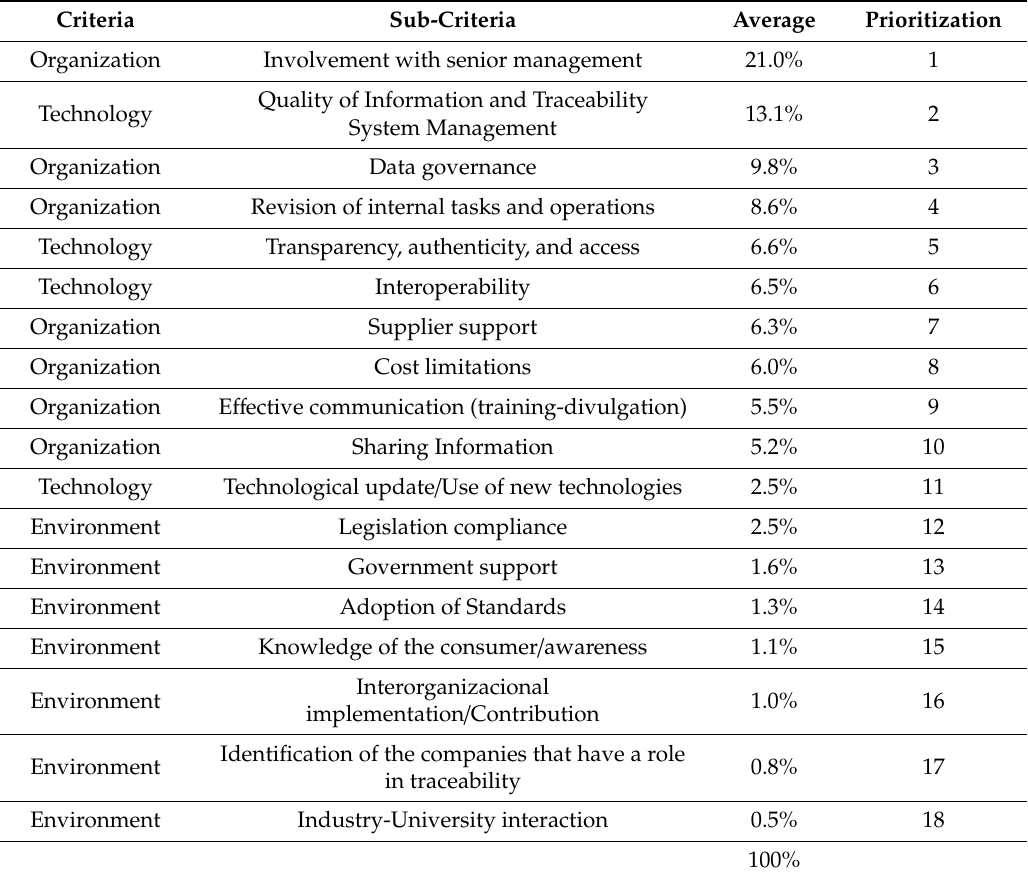
Table 8. Prioritization of the